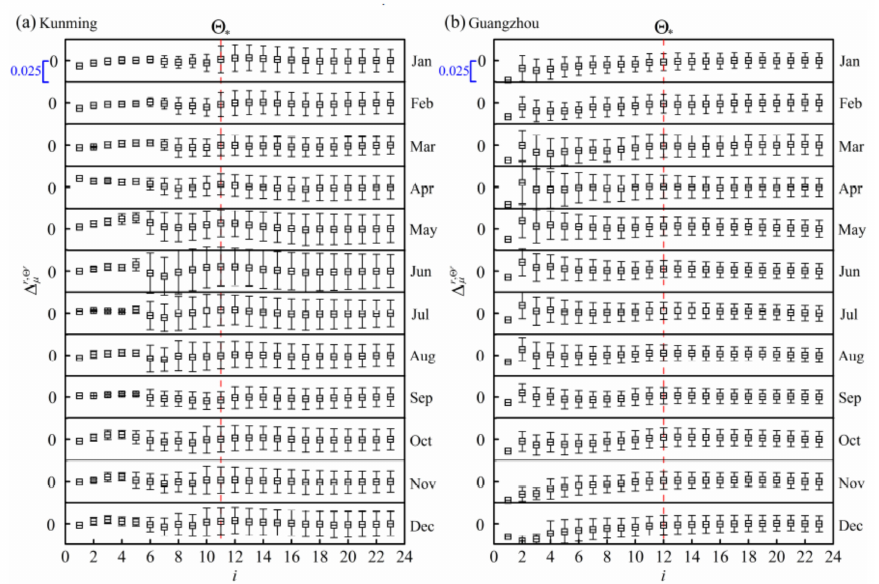
Figure 9. Temporal stability checks of accumulated mean surface albedo at ( a ) Kunming and ( b ) Guangzhou